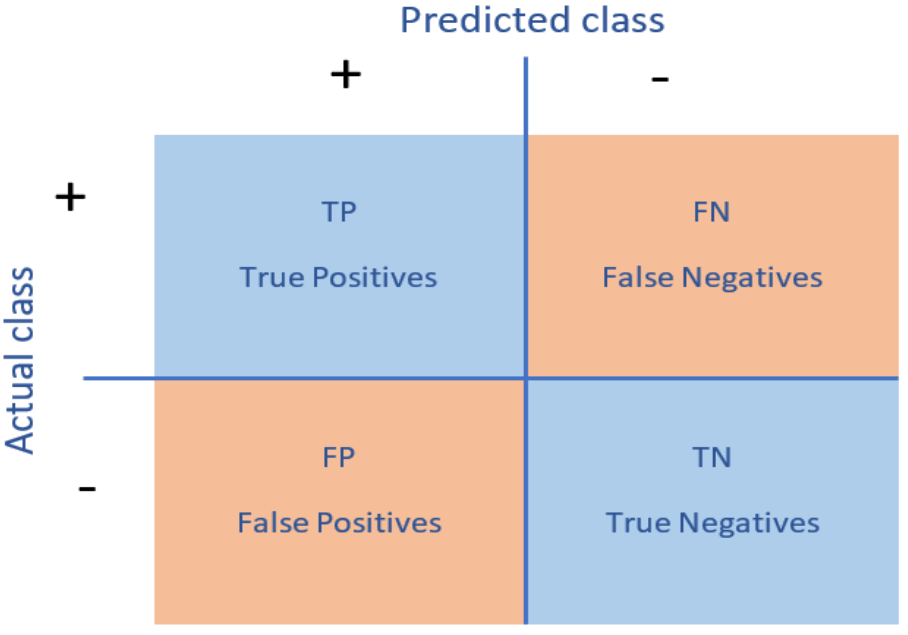
Figure 6. Confusion matrix.